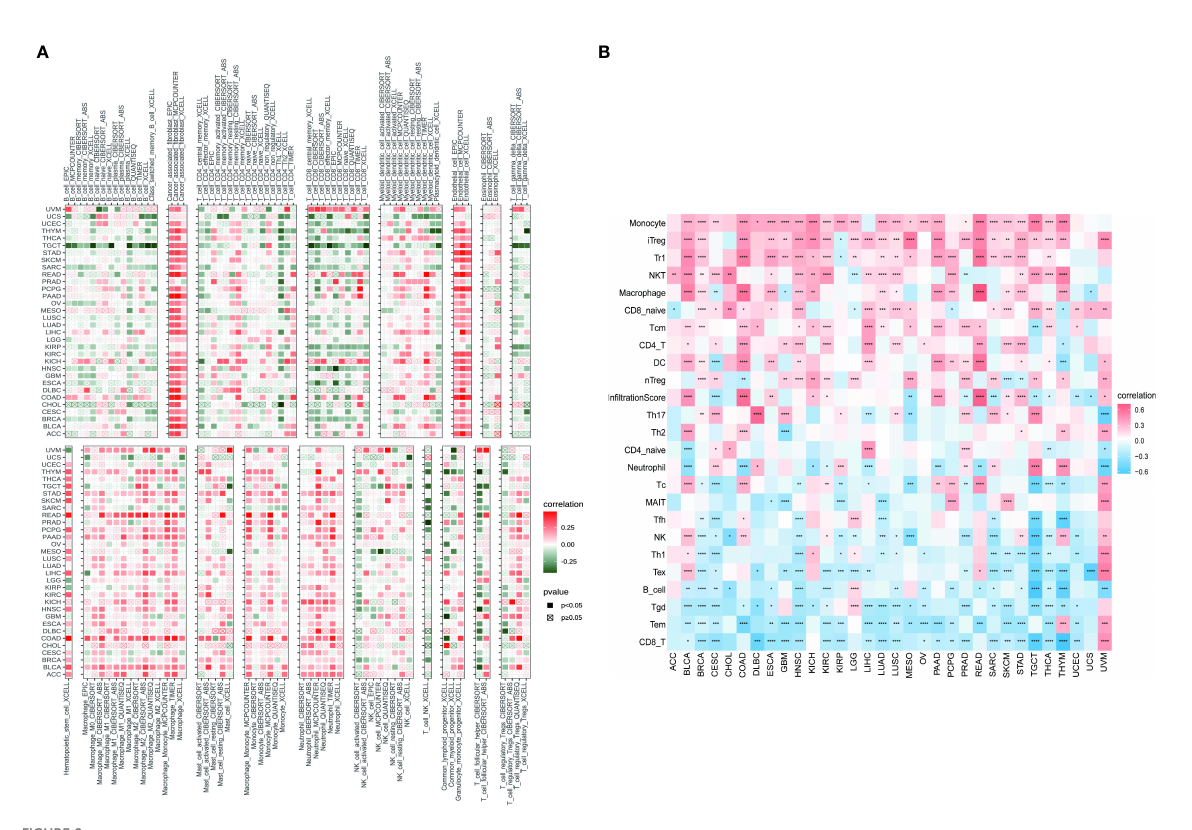
FIGURE 9 Relationship between PXDN expression and tumor immune cell in fi ltration. (A) Relationship between PXDN expression and tumor immune cell in fi ltration based on the TIMER2 database. (B) Relationship between PXDN expression and tumor immune cell in fi ltration based on the ImmuneCellAI database. Red and blue or green represents positive and negative correlations, respectively, while white represents p > 0.05. *p < 0.05, **p < 0.01, ***p < 0.001, ****p <